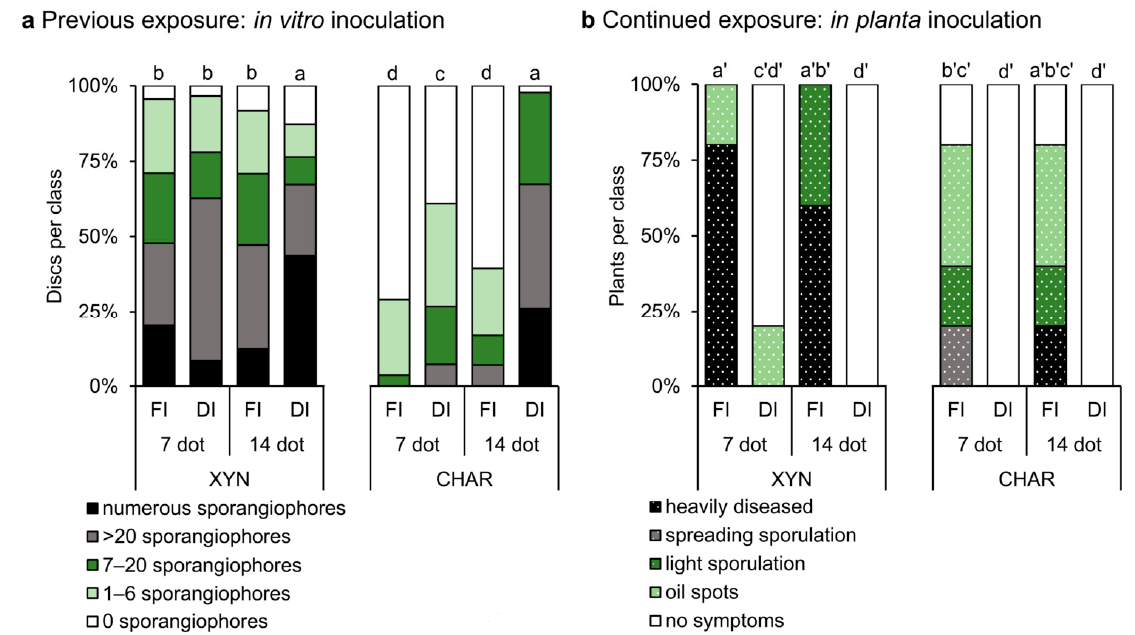
Figure 3. Influence of drought stress on the susceptibility of Xynisteri (XYN) and Chardonnay (CHAR) to P. viticola . The control plants were fully irrigated (FI), while the drought-stressed plants were exposed to deficit irrigation (DI). Different letters indicate significant differences (Mann–Whitney U -test; p = 0.05). ( a ) Previous exposure to drought stress: Plants were exposed to 7 or 14 dot before the leaves were detached (previous exposure to full/deficit irrigation; see Figure 1). Leaf discs were inoculated with a P. viticola sporangial suspension and each disc was evaluated 5 days later by counting the sporangiophores. Five plants of each cultivar were used per treatment, resulting in an average of 60 discs per treatment. Leaf discs from one plant of each cultivar, sampled at 14 days of deficit irrigation, could not be evaluated due to leaf scorch. ( b ) Continued exposure to drought stress: Plants were exposed to 7 or 14 dot prior to being sprayed with a P. viticola sporangial suspension (continued exposure to full/deficit irrigation; see Figure 1). The irrigation regimen was maintained until disease severity was evaluated 7 days later. Five plants of each cultivar were used per treatment.